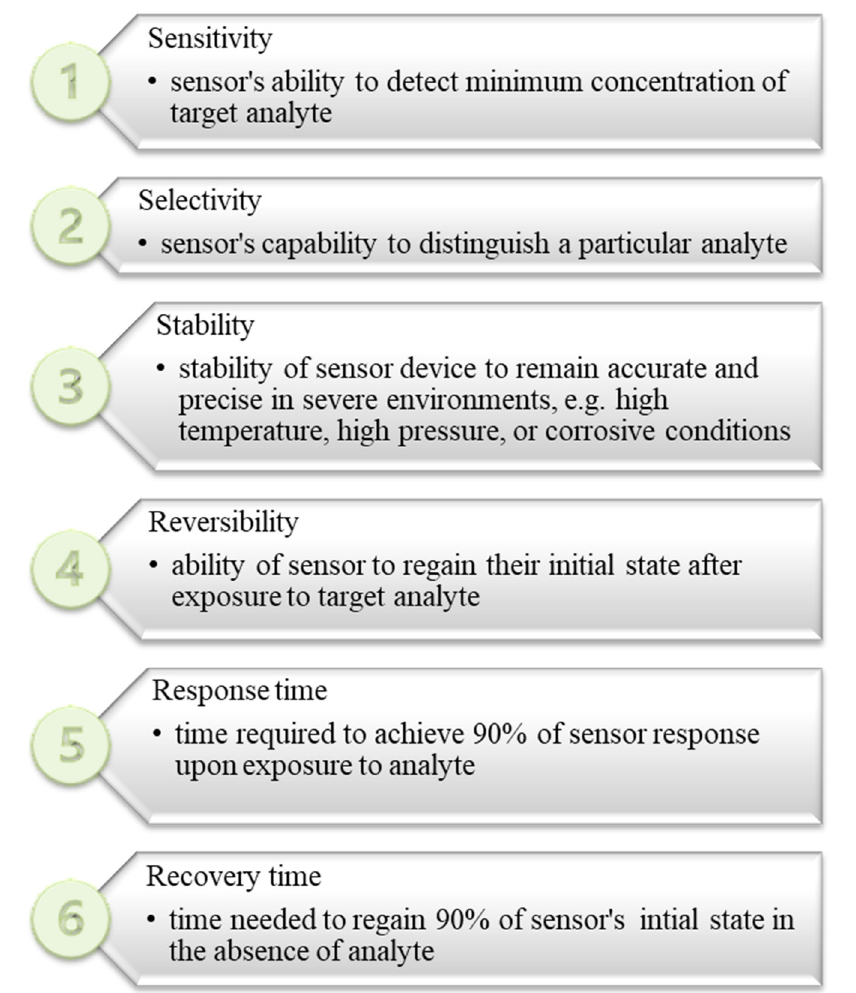
Figure 7. Key components in chemical sensors.